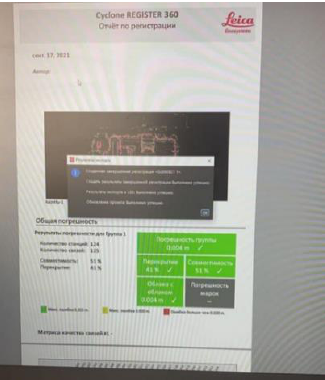
Figure 9. Completing the registration process.